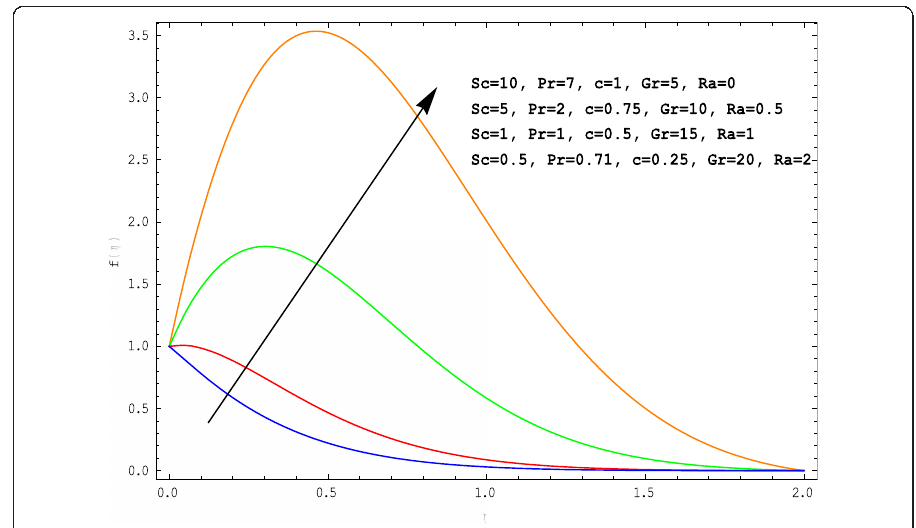
Fig. 2 Fluid velocity for different values of Sc , Pr, c , G r , and Ra